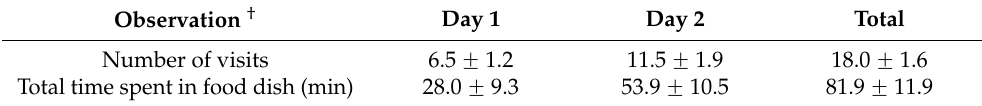
Table 1. Average number of visits and time spent (min ± S.E.) in the food dish by individual Plodia interpunctella females during two consecutive 10-h periods that each included an 8-h scotophase ( n = 4).